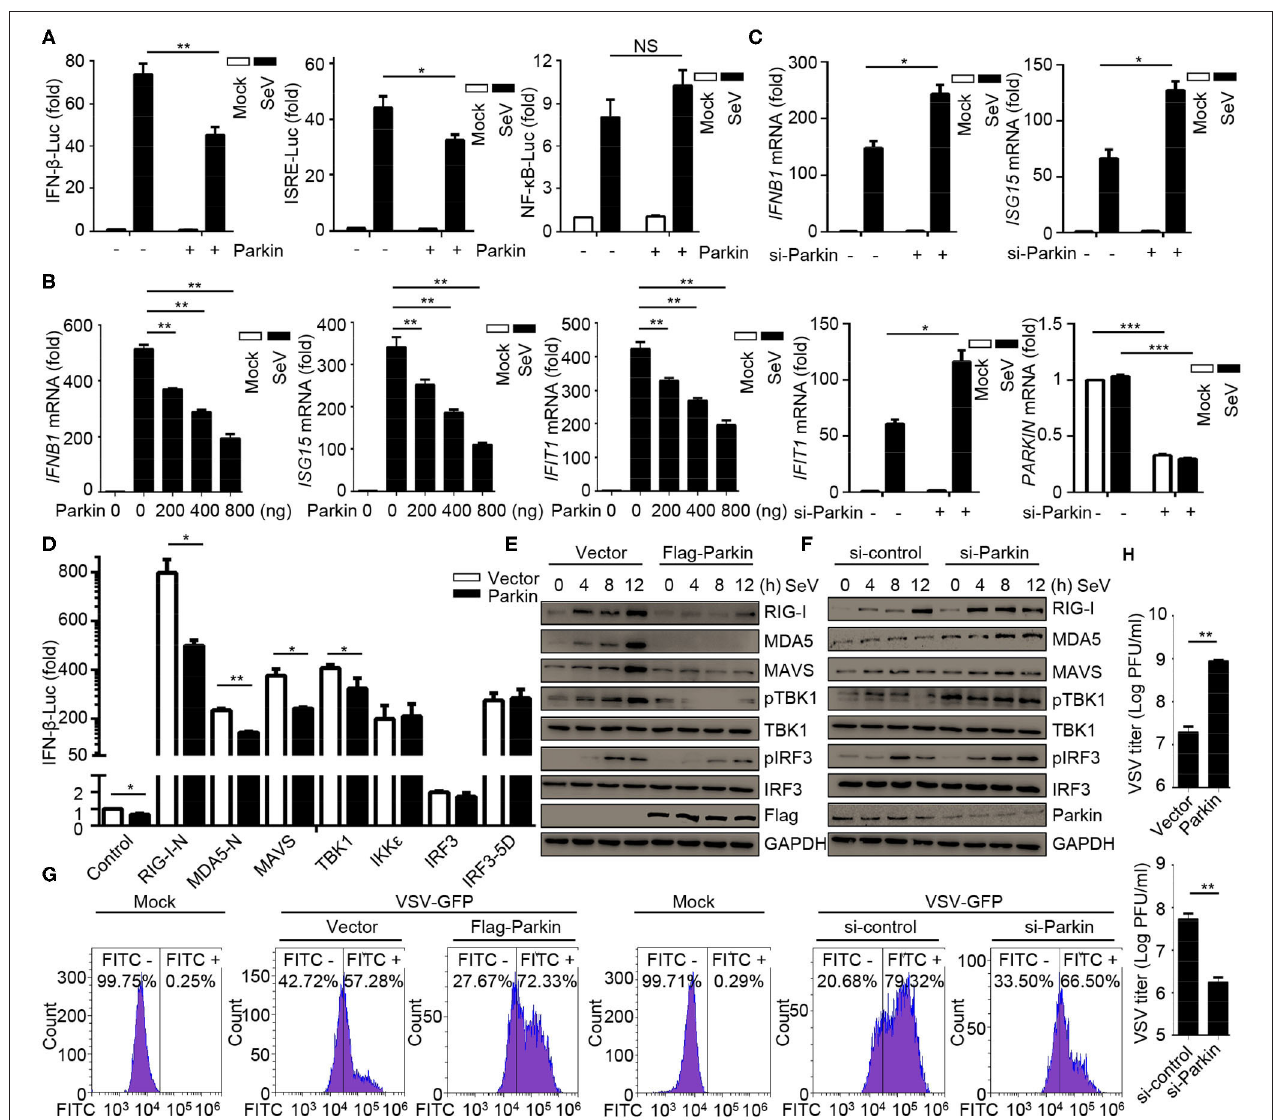
FIGURE 2 | E3 ubiquitin-protein ligase Parkin inhibits type I IFN responses. (A) HEK293 cells were co-transfected with vector or Parkin and IFN- β , ISRE, or NF- κ B luciferase reporter for 24h, then unstimulated or stimulated with SeV for 10h, and subjected to luciferase assays. (B) HEK293 cells were transfected with vector or different quality of Parkin for 24h, then unstimulated or stimulated with SeV for 10h, and subjected to quantitative RT-PCR analysis. (C) PMA-differentiated THP1 cells were transfected with si-control or si-Parkin for 48h, then unstimulated or stimulated with SeV for 10h, and subjected to quantitative RT-PCR analysis. (D) Vector or Parkin were co-transfected with IFN- β luciferase reporter and RIG-I-N, MDA5-N, MAVS, TBK1, IKK ε , IRF3, or IRF3-5D for 24h in HEK293 cells, then subjected to luciferase assays. (E) HEK293 cells were transfected with vector or Flag-Parkin for 24h, then unstimulated or stimulated with SeV for different times, and the whole cell extracts were subjected to IB analysis. (F) HEK293 cells were transfected with si-control or si-Parkin for 48h, then unstimulated or stimulated with SeV for different times, and the whole cell extracts were subjected to IB analysis. (G) HEK293 cells were transfected with vector or Parkin for 24h, or transfected with si-control or si-Parkin for 48h, then cells were infected with or without VSV-GFP (MOI = 0.01), and then cells were subjected to flow cytometer assays. (H) HEK293 cells were transfected with vector or Parkin for 24h, or transfected with si-control or si-Parkin for 48h, then cells were infected with VSV-GFP (MOI = 0.01), and the supernatants were subjected to VSV plaque assays. The data represent the average of three independent experiments and were analyzed by unpaired t- test. All data represent the mean ± S.D. * p < 0.05, ** p < 0.01, and *** p < 0.001.